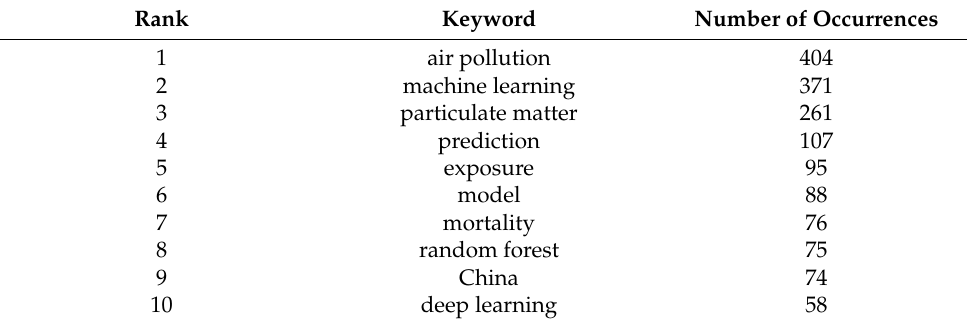
Figure 4. Map of co-occurrences of keywords . Table 3. Ten topmost co-occurring keywords .